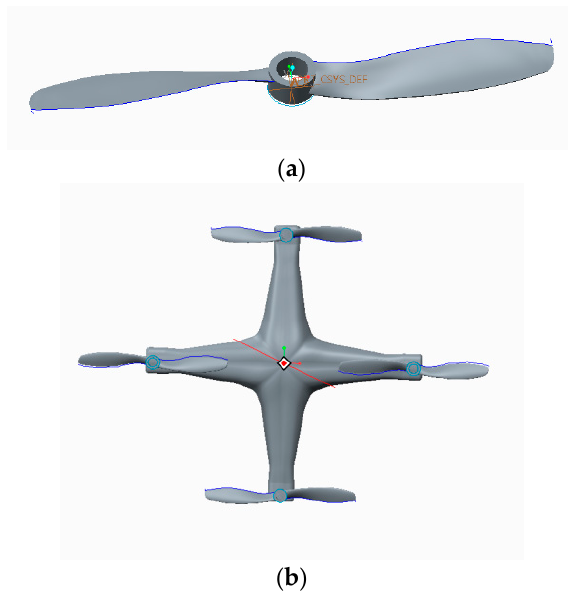
Figure 5. 3D models used for the DJI phantom UAV. ( a ) Rotor blade; ( b ) UAV.